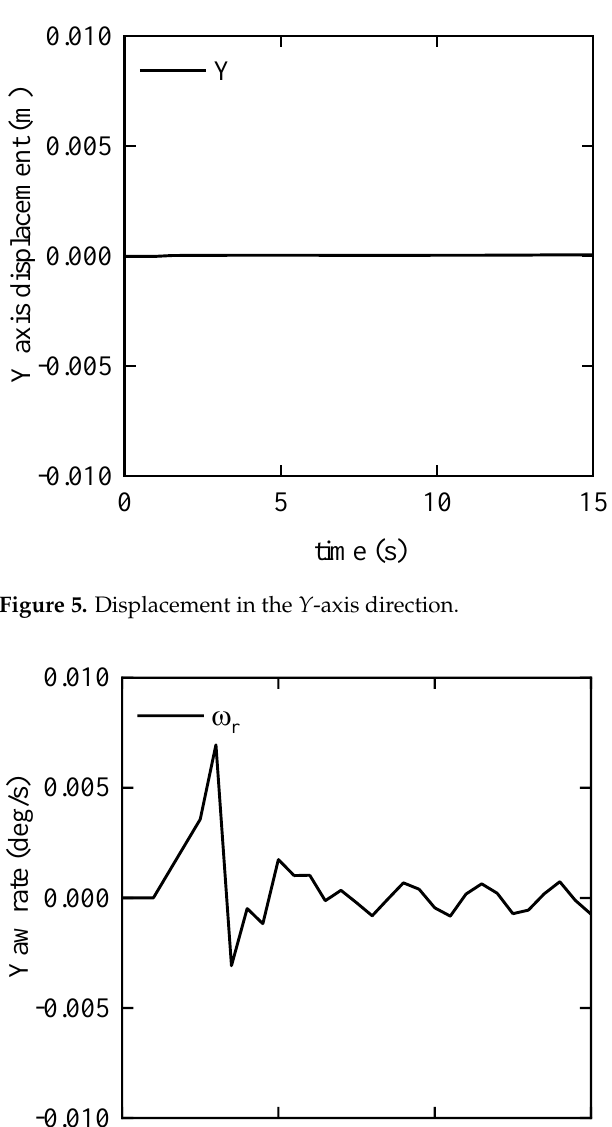
Figure 4. Longitudinal speed.